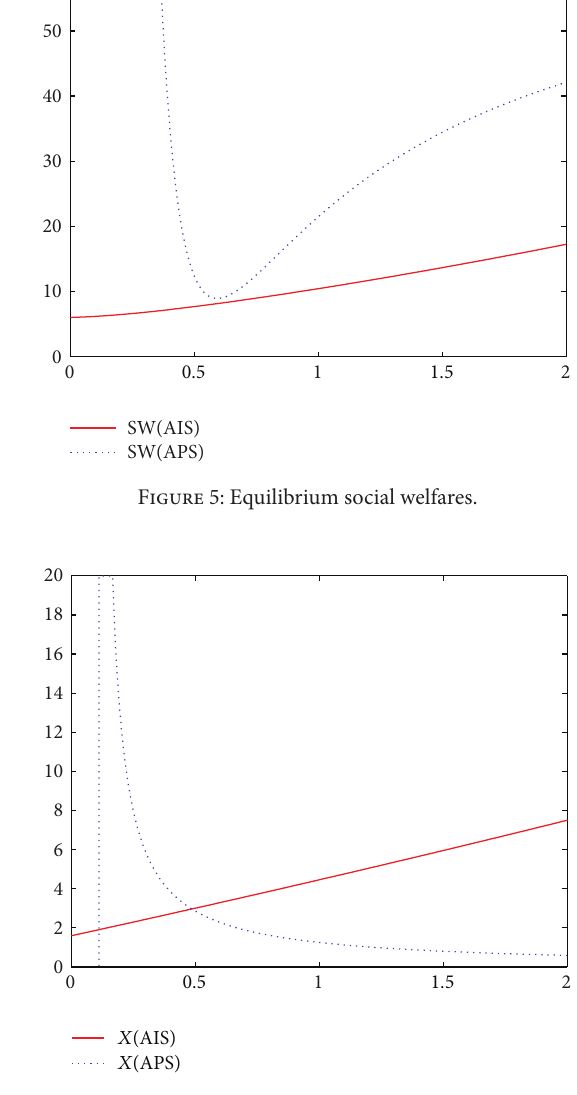
Figure 6: Total R&D